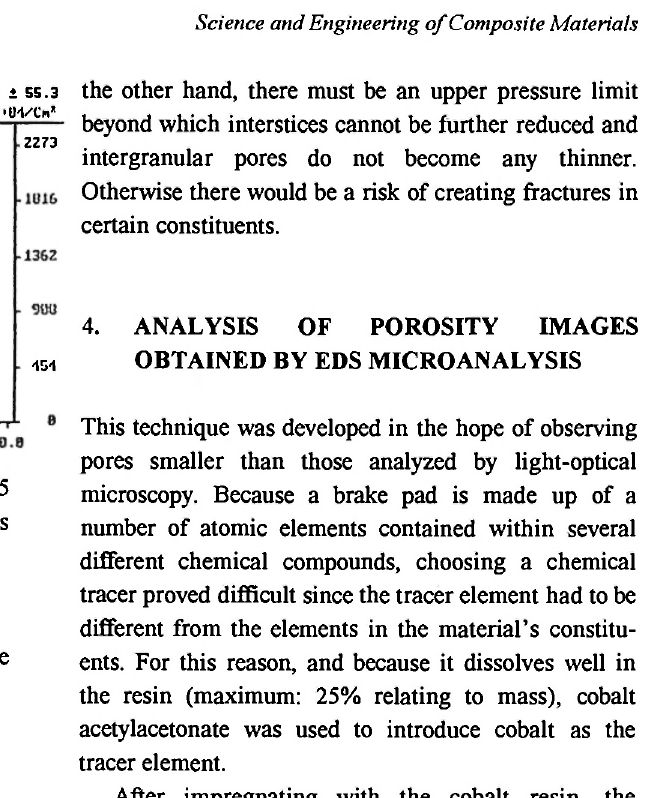
Fig. 1-4: Orientation distribution histograms of A0P15 for 240 fields (pores with a surface area less than 20 μτη 2